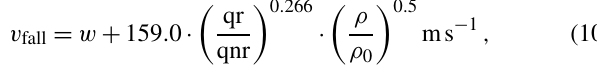
6g, autoconversion increases with